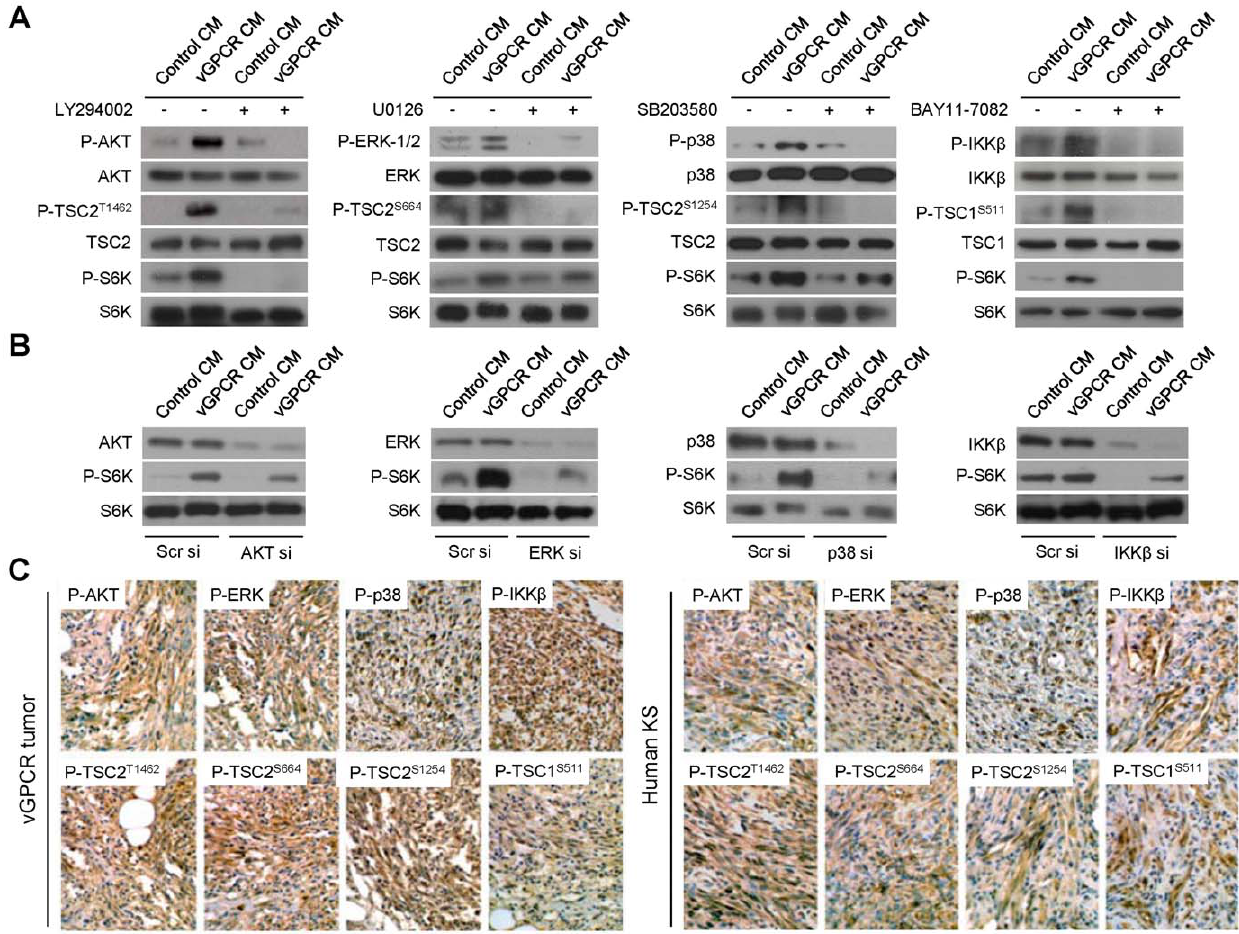
Figure 2. vGPCR secretions regulate TSC/mTOR through multiple signaling pathways invitro and invivo . (A) HMEC1s were pretreated with vehicle or inhibitors of the AKT, ERK, p38 or IKK b pathways, LY294002 (50 m M), U0126 (50 m M), SB203580 (50 m M) or BAY11-7082 (40 m M). Cells were then exposed to media conditioned by control cells (Control CM) or vGPCR-expressing cells (vGPCR CM). Phosphorylation levels of the corresponding kinase (AKT, ERK1/2, p38 or IKK b ), TSC2/1 targeted phosphorylation site (P-TSC2 T1462 , P-TSC2 S664 , P-TSC2 S1254 or P-TSC1 S511 ), and S6K are shown. (B) HMEC1s were transfected with Scrambled siRNA or siRNA for AKT, ERK (ERK1 and 2), p38 or IKK b . Cells were then exposed to media conditioned by control or vGPCR-expressing cells. Levels of the corresponding kinase (AKT, ERK1/2, p38 or IKK b ) and S6K are shown. (C) Immunohistochemical staining of vGPCR tumors and human KS with antibodies against P-AKT, P-ERK, P-p38 or P-IKK b , and the corresponding TSC2/1 targeted phosphorylation site, P-TSC2 T1462 , P-TSC2 S664 , P-TSC2 S1254 or P-TSC1 S511 .